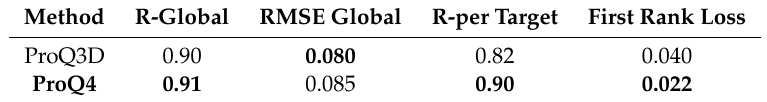
Table A4. Global-score performance comparison of ProQ4 and ProQ3D on CASP11 [21].